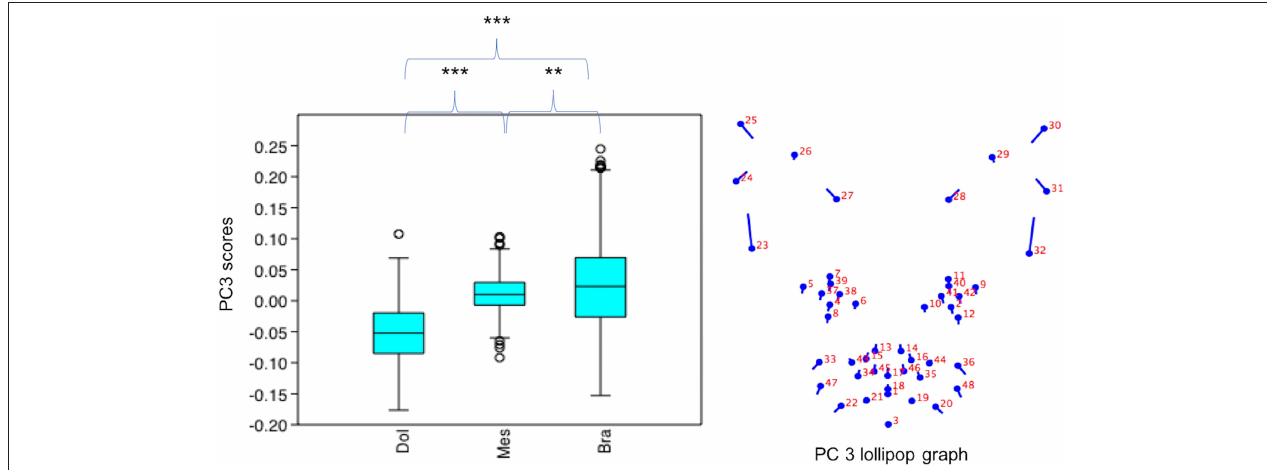
FIGURE 3 | Boxplot with minimum, first quartile, median, third quartile, maximum values and outliers for PC3 scores for each of the cephalic types; Dol, dolichocephalic; Bra, brachycephalic; Mes, mesocephalic; n = 1,888. ** p < 0.01, *** p < 0.001. Relative landmark variation for PC3 represented via lollipop graph. Lines protruding from each landmark indicate direction and magnitude of movement, with higher PC3 scores reflecting a greater distance along the line from the circular nodes. Images produced using MorphoJ, Version 1.06d (57).